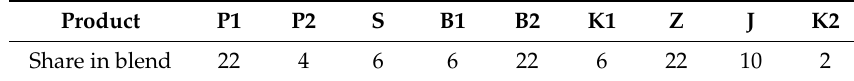
Table 6. Composition of blend for tests.